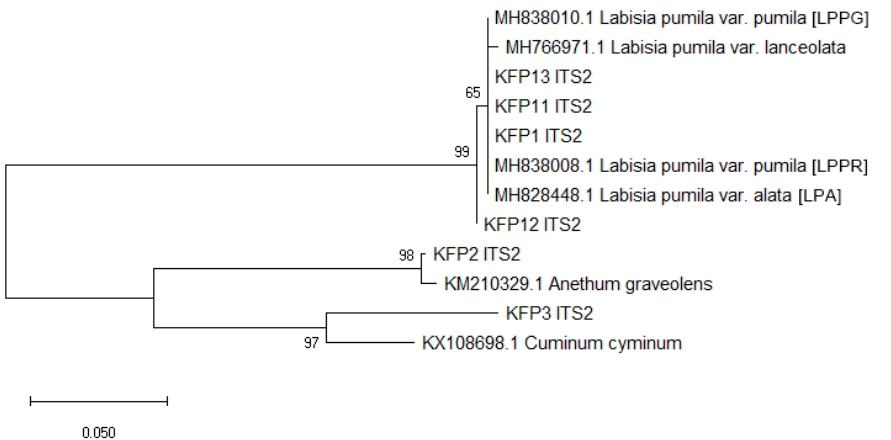
Figure 5. NJ tree of L. pumila HMPs ITS2 trimmed sequences compared to reference sequences generated in this work (MH828448.1, MH838008.1, and MH838010.1) and another DNA reference barcode retrieved from GenBank (MH766971.1). KFP: Kacip Fatimah product. Numbers on the node of each branch are the bootstrap values for 1000 replicates.